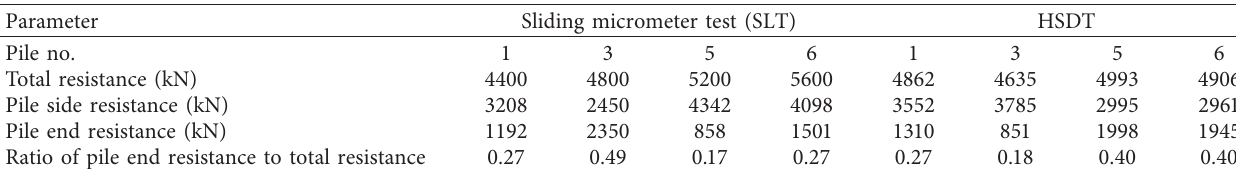
Parameter Sliding micrometer test (SLT) HSDT Pile